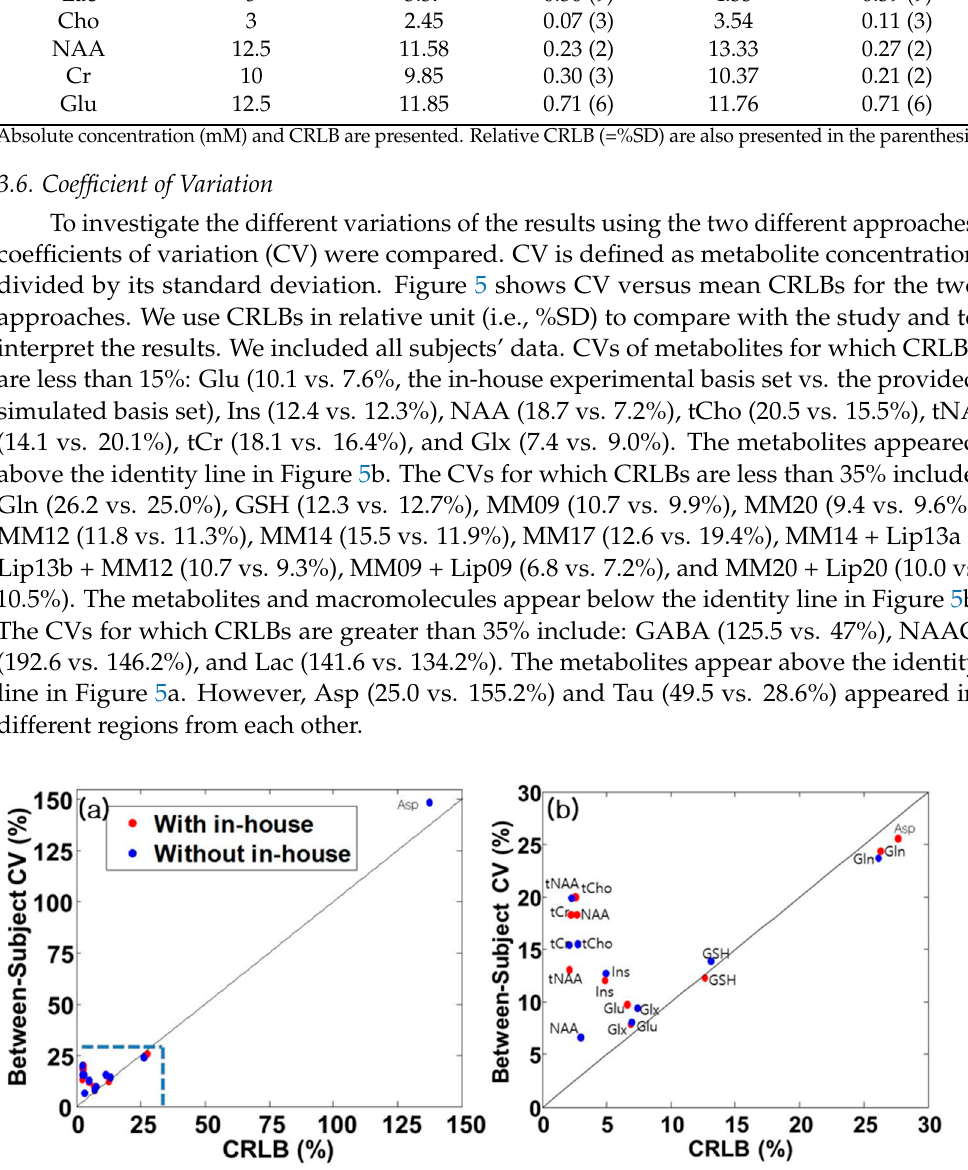
Figure 5. Coefficients of variation (CV) vs. CRLB and its zoomed Figure. ( a ) emphasizes that the CRLB of Asp using without in-house basis sets is remote from others. ( b ) shows that quantified metabolites are distributed within the CRLB < 35% and above.